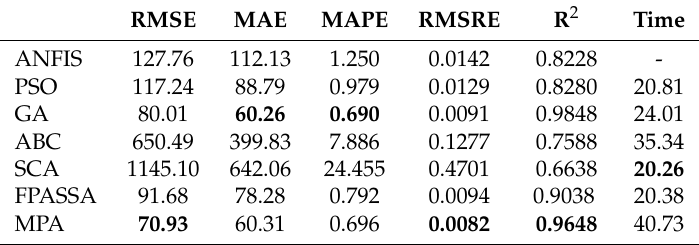
Table 6. Results of